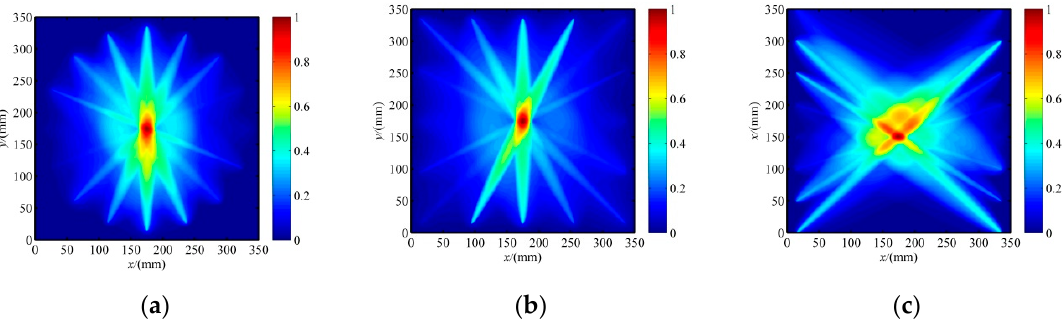
Figure 7. The initial reconstruction image of a crack without considering the crack orientation. ( a ) The image with a circular array. ( b ) The image with a square array. ( c ) The image with a parallel linear array. Table 2. The resultant imaging accuracy of a crack without considering the crack orientation. Pattern of the PZT Sensor Array Real Location Predicted Location Damage Shape Circular (175, 175) (176, 176) Ellipse Square (175, 175) (176, 176) Oblique ellipse Parallel linear (175, 150) (175, 151) Elongated shape